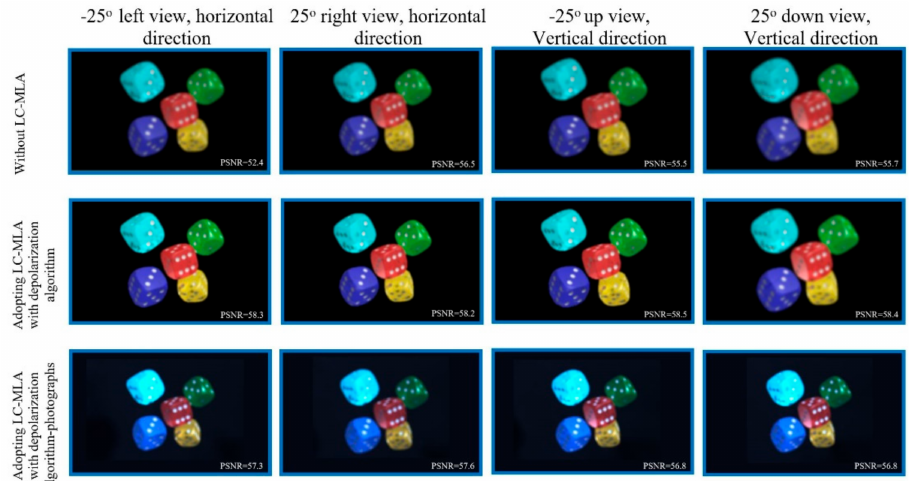
Figure 7. Photographs shot at three different views of the proposed light field display system. Adopting LC-MLA with depolarization algorithm-photographs at different views. There is a video for representing the result, as provided in Supplementary